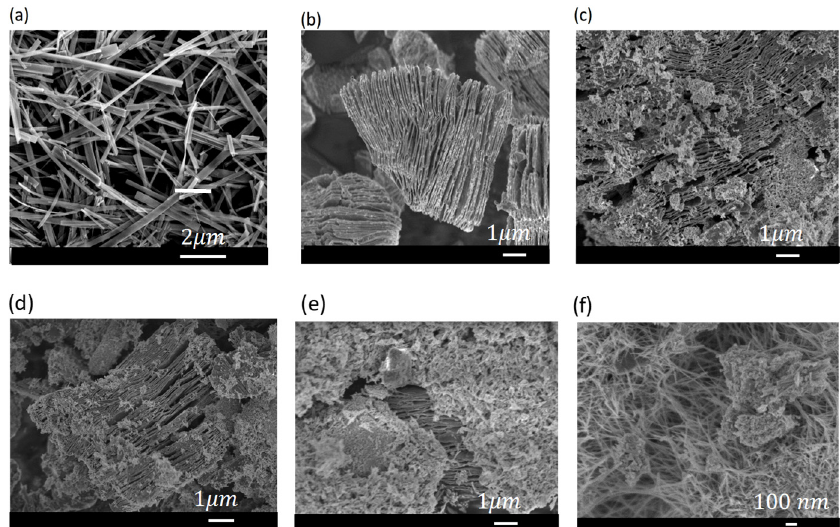
5 of 12 Figure 1. Diagram showing the acetone testing system. Acetone and humidity are generated by the Owlstone vapor and humidity generator and delivered into the sensor testing box. The sensitivity of the sensor films to acetone at a given RH value can be calculated as the percentage change in resistance of the sensing material with and without exposure of acetone: 𝑆% (cid:3404) (cid:3436)𝑅3 (cid:3398) 𝑅2 𝑅1 (cid:3440) (cid:3400) 100 (1) Here, S is sensitivity (%) to acetone, R1 is the baseline resistance (M Ω ) at room RH, R2 is the resistance (M Ω ) at the controlled RH without acetone in ‐ flow and R3 is the resistance (M Ω ) at the same controlled RH with acetone in ‐ flow. 3. Results and Discussion 3.1. Characterization The microstructures and morphologies of the as ‐ synthesized nanomaterials: KWO, Ti 3 C 2 T x , KWO/Ti 3 C 2 T x nanocomposites have been investigated by SEM. As shown in Figure 2a, the SEM image of KWO clearly shows a three ‐ dimensional mesh of randomly orientated and interconnected nanorods with several μ m in length and 20–50 nm in diameter. The SEM image of pristine Ti 3 C 2 T x MXene (Figure 2b) exhibits multilayered structure and accordion ‐ like morphology. Figure 2c–2f